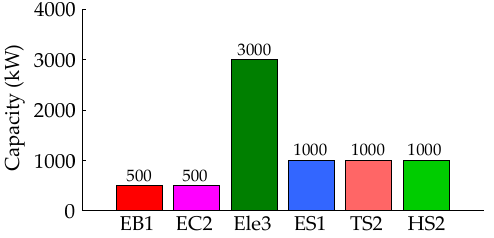
Figure 7. Equipment selection and capacity configuration of DES 0.